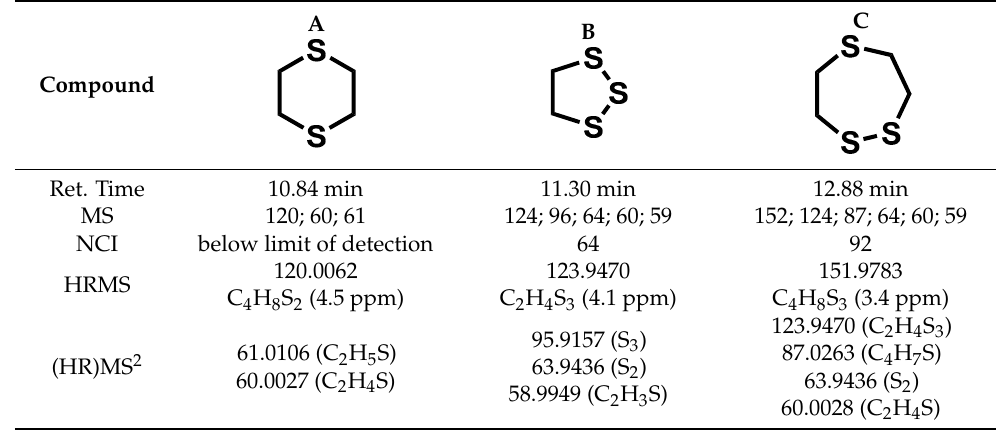
Table 2. Summary of the MS data from compounds of interest in carbonate-based systems.